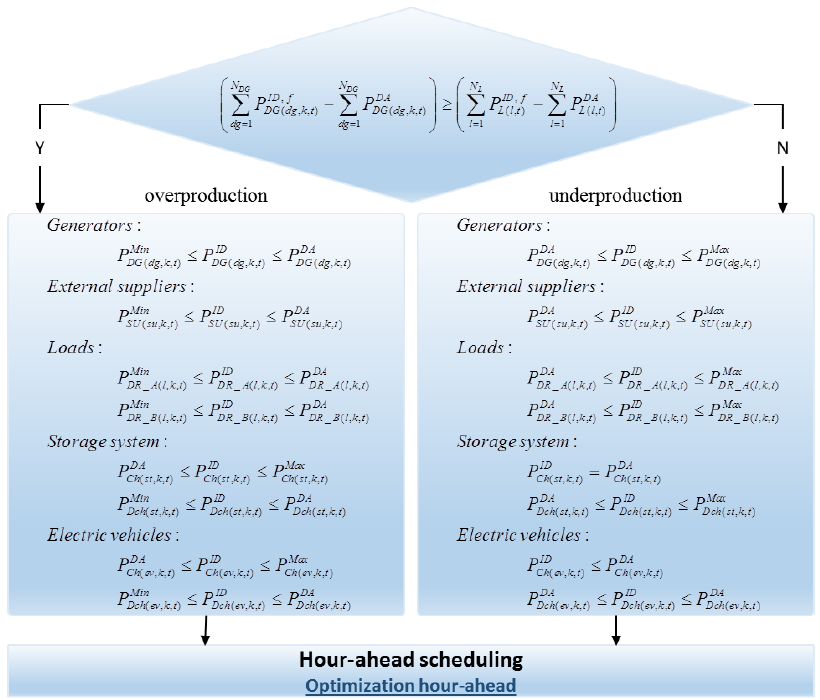
Figure 2. Intraday (hour-ahead) scheduling diagram.